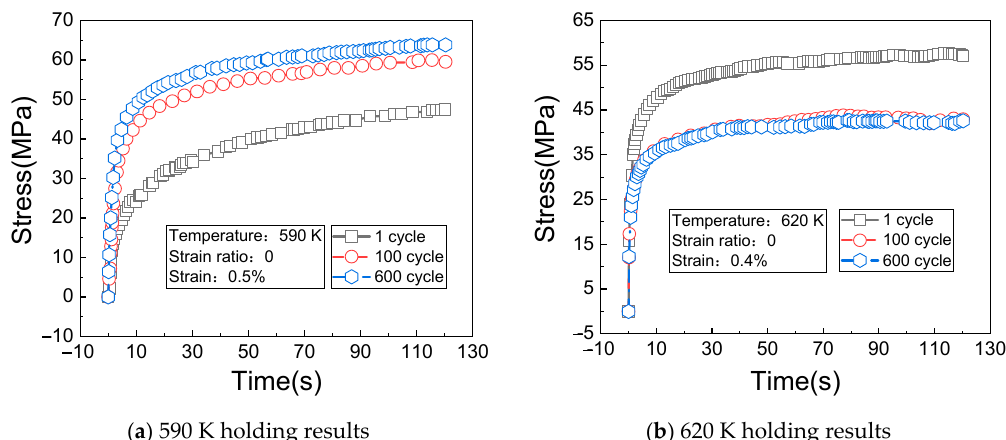
Figure 13. Stress relaxation results of holding at 590 K and 620 K. ( a ) 590 K holding results; ( b ) 620 K holding results.